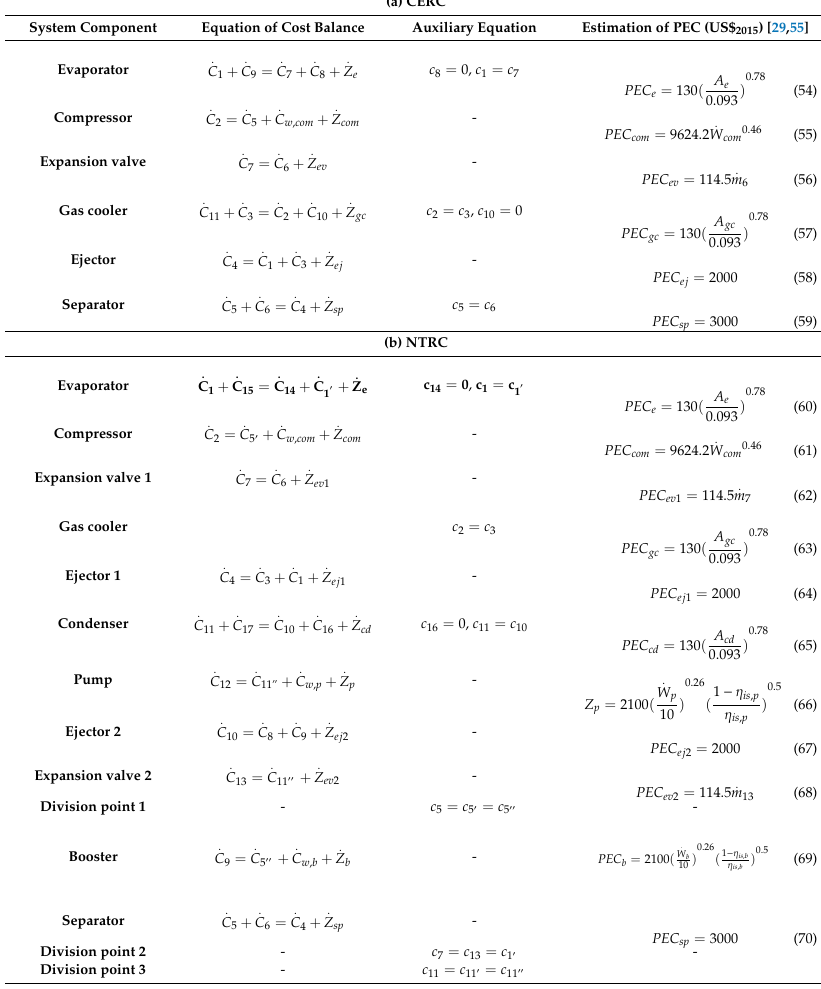
Table 4. Equations of CERC and NTRC cost balance for the